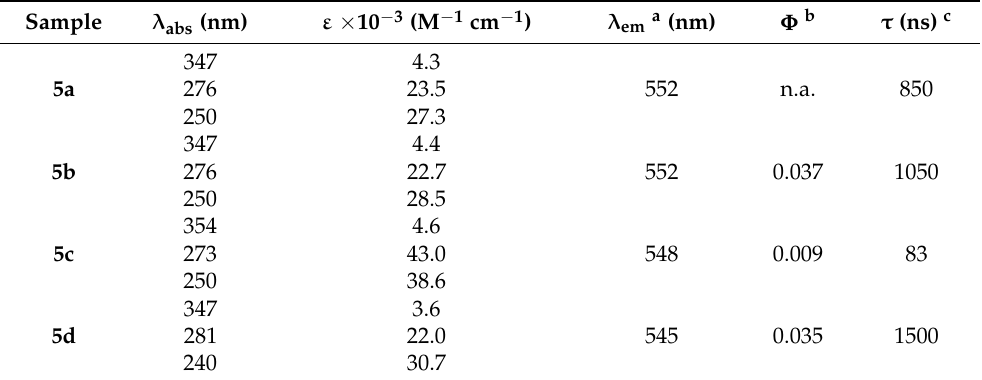
Table 2. Photophysical properties of Cu(I) complexes 5a , 5b , 5c and 5d in solution at room temper- ature.